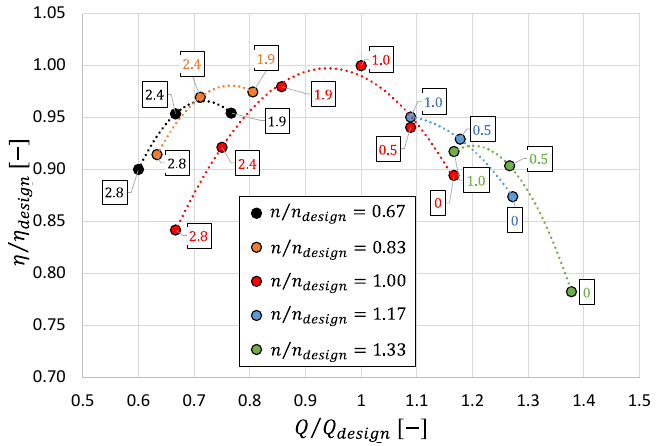
Figure 12. Normalized efficiency curves versus the fraction of the design flow rate under the constant design net head. Numbers in the squares represent the ratio between actual and design guide vane stagger angles.